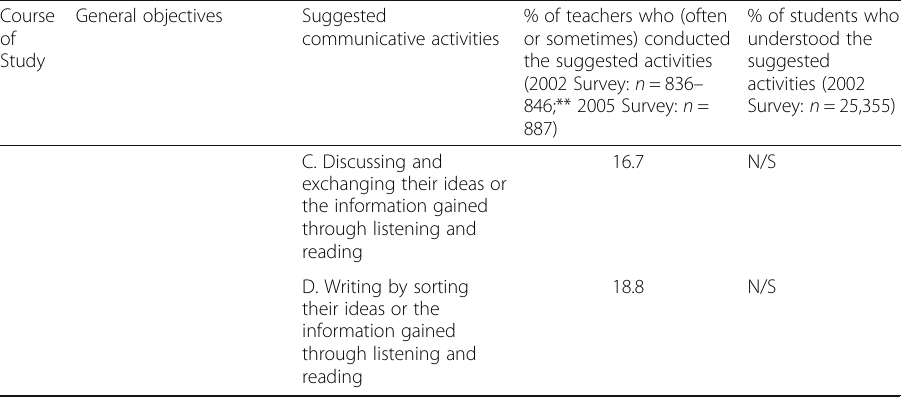
Table 1 Objectives, Suggested Communicative Activities, and Actual Classroom Practices for the 1994 – 2002 and 2003 – 2012 Courses of Study*